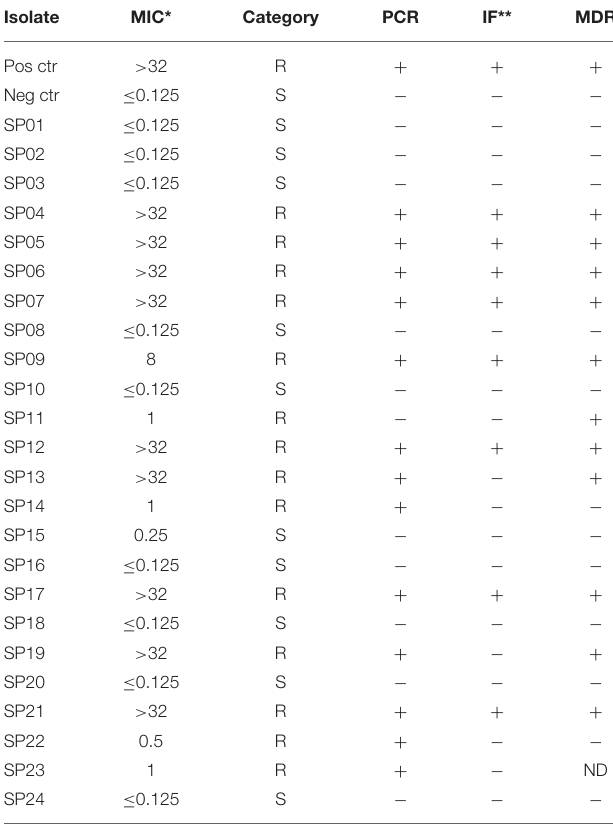
TABLE 1 | Results of methicillin resistance investigation in the SP isolates and their MDR